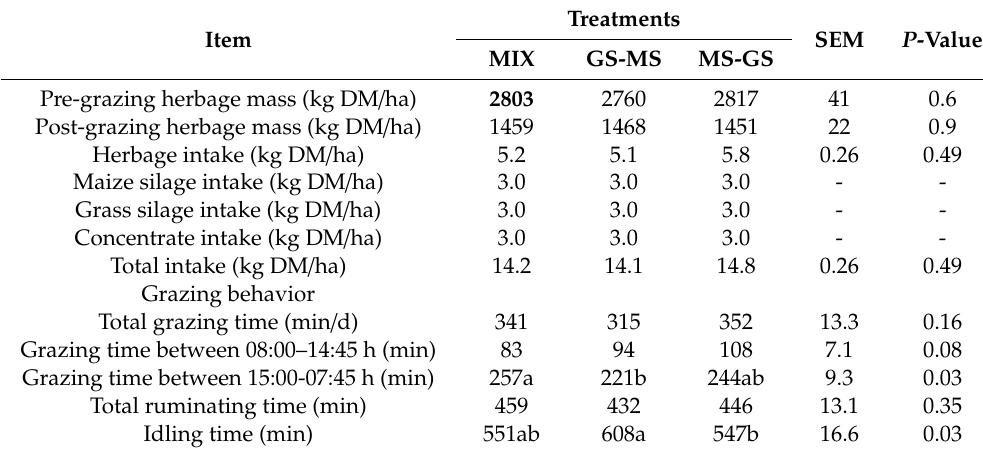
Table 2. Herbage mass, dry matter intake and grazing behavior and milk production of grazing dairy cows supplemented with 50:50 grass and maize silage in the morning and afternoon (MIX), grass silage in the morning and maize silage in the afternoon (GS-MS) or maize silage in the morning and grass silage in the afternoon (MS-GS). Treatments Item SEM P -Value